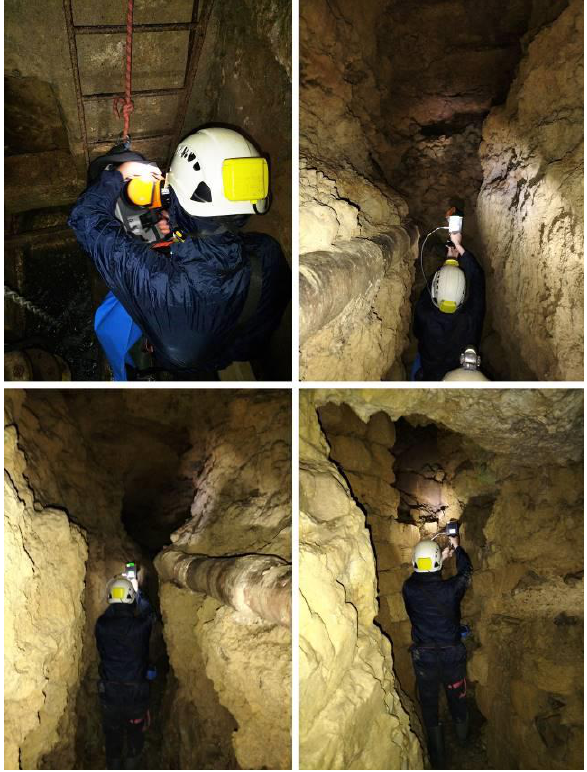
Figure 7 . Some phases of the survey in “Gesuitico alto” qanāt